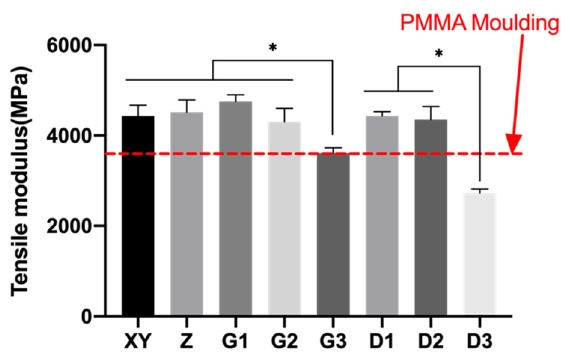
Figure 12. Mean and standard deviations of tensile modulus of 3D-printed PEEK. * p < 0.05.